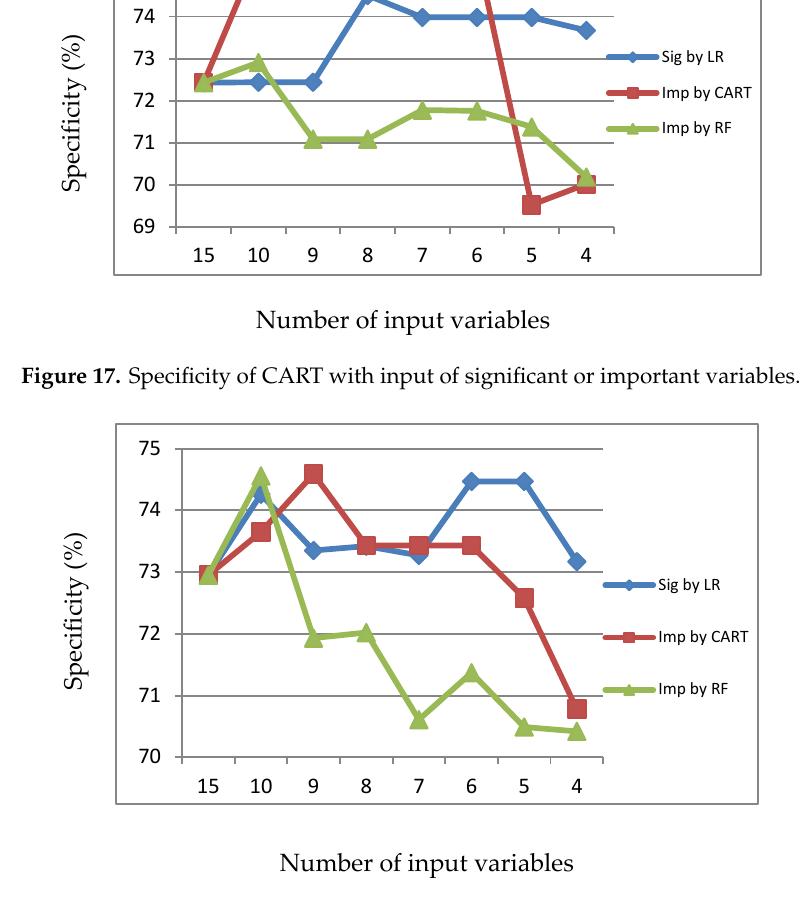
Figure 18. Specificity of RF with input of significant or important variables.